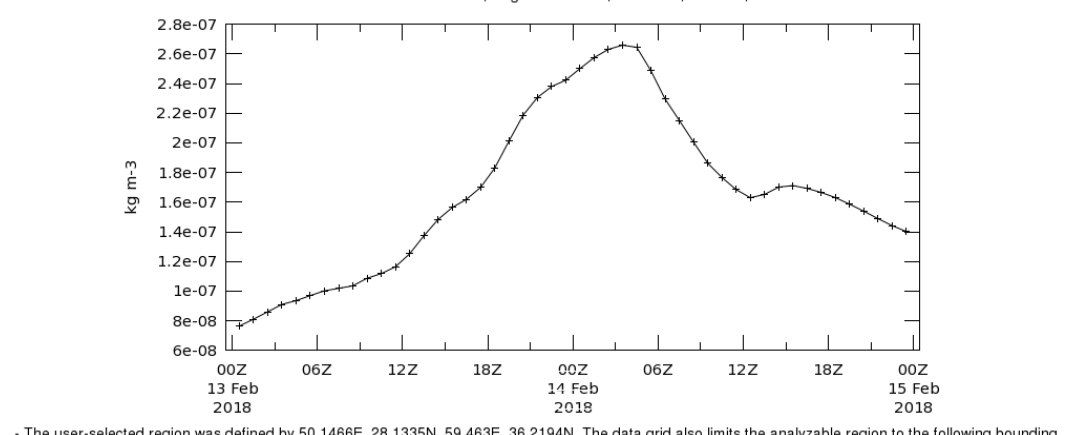
Figure 20. Surface concentration of dust (µg/m 3 ) in the Modern-Era Retrospective analysis for Research and Applications, version 2 (MERRA-2) reanalysis for 14 February 2018.